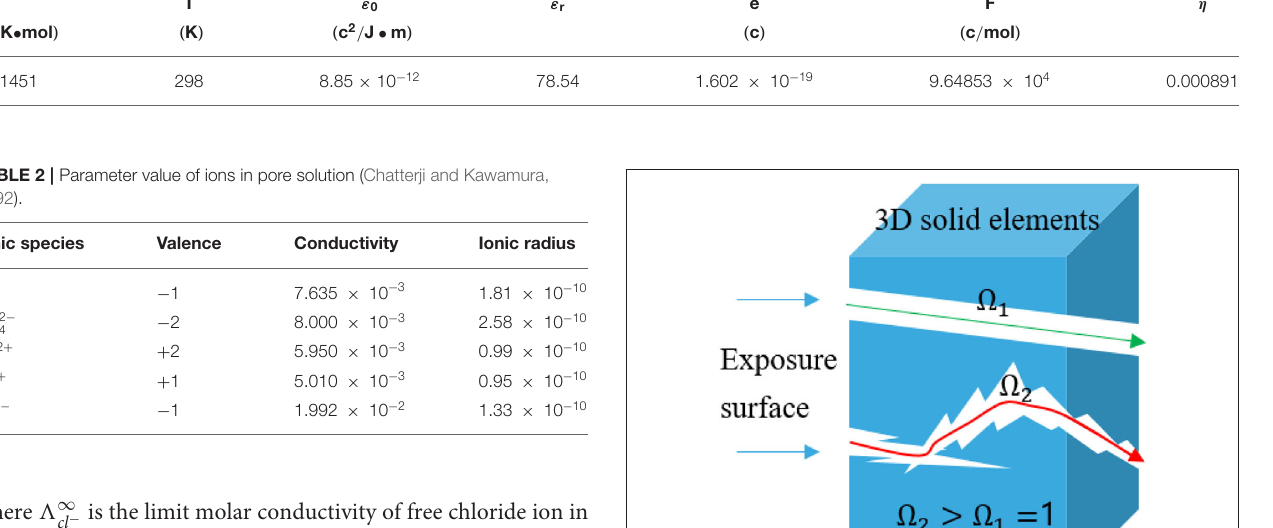
TABLE 1 | Parameter value in calculation formula of conductivity and free chloride ion diffusion coefficient. R g